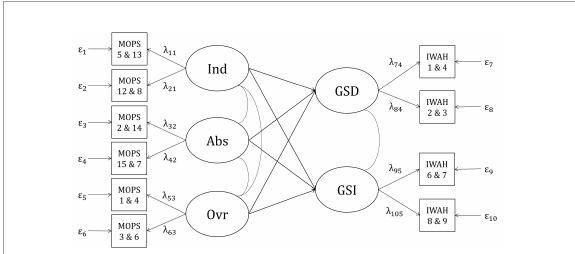
FIGURE5 Negative regression model for the English sample. Ind, indifference; Abs, abuse; Ovr, over-control; GSD, global self-definition; GSI, global self-investment; MOPS, “Measure of Parental Style”; IWAH, “Identification With All Humanity scale.” Latent factors (e.g., Ind) are displayed in circles. Indicators (e.g., MOPS 5 and 13) are displayed in squares. Numbers beneath the abbreviations of questionnaires indicate item numbers of the items forming particular indicators (e.g., Item 5 and item 13 from the MOPS form one indicator displayed as MOPS 5 and 13). Curved lines indicate correlations between latent factors. Arrows with factor loadings (e.g., λ 11 ) illustrate the assumption that the indicators are predicted by specific latent factors. Residual variances are displayed below the indicators (e.g., ε 1 ). Arrows from latent variables to other latent variables (e.g., Ind → GSD) illustrate the idea that one variable on which the arrow